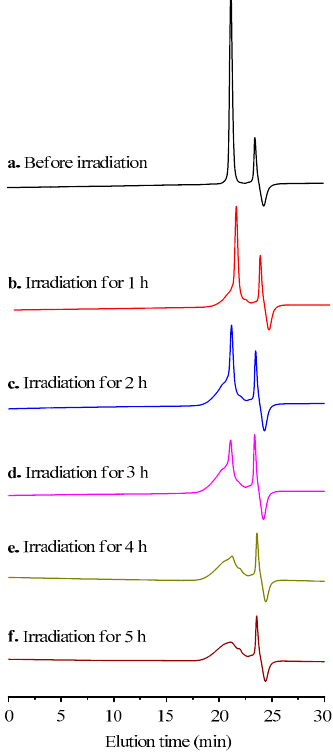
Figure 3. Size-exclusion chromatography (SEC) chromatograms of samples obtained from ( R )-BINOL in a CH 3 CN solution upon irradiation ([( R )-BINOL] o = 1.0 × 10 − 3 M, cell path = 5 mm, solution volume = ca. 1.75 mL) and a standard ( R )-BINOL sample: ( a ) standard ( R )-BINOL; ( b – f ) samples after irradiation for 1 h, 2 h, 3 h, 4 h, and 5 h, respectively.